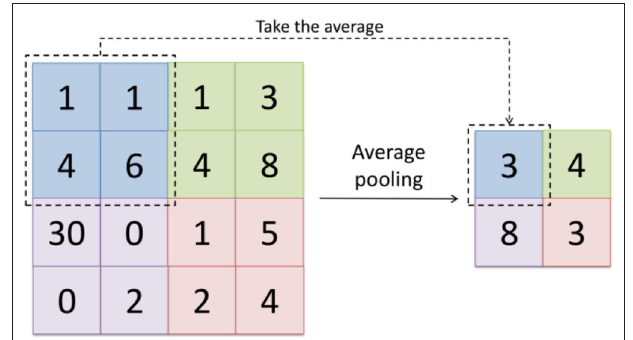
FIGURE 5 | The average pooling